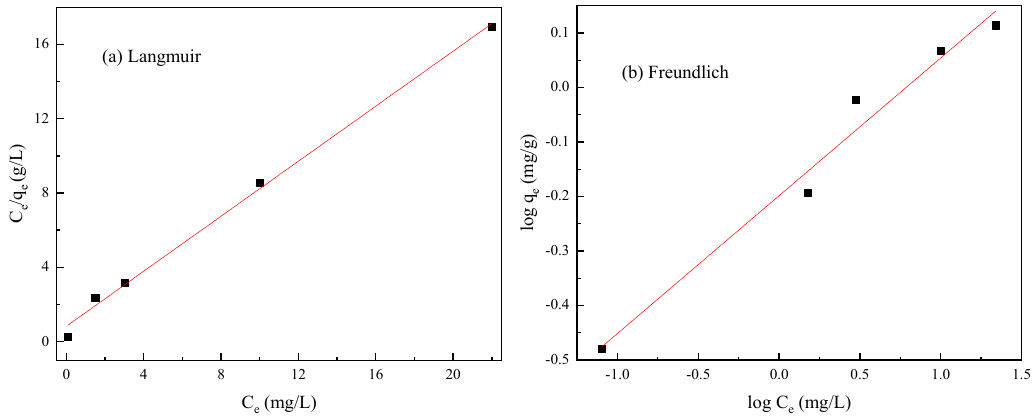
Figure 13. Schematic diagram of REC modification and Cr(VI) and Pb(II) adsorption. 4. Conclusions This investigation showed that the novel modifier Fe 3+ chemisorption on the REC surface improved its adsorption capacity for Cr(VI) and Pb(II). For Fe-REC, the potential exhibited a positive shift within the studied pH range. In the XPS survey spectra, significant characteristic peaks of Fe 2p appeared, which was the oxidation state of Fe(III) (Fe–O, Fe–OH, Fe–OOH) formed on the Fe-REC surface. The Cr(VI) adsorption mechanism was mainly due to the reaction between the iron hydroxy complex of modifier (FeOH 2+ , Fe(OH) 2+ and Fe(OH) 3 (aq)) and the major components of hexavalent chromium solution (HCrO 4– and CrO 42– ) to promote its adsorption behavior. From zeta potential results, there was an obvious negative shift after Cr(VI) ions was adsorbed by Fe-REC and the natural potential reduced to –33.2 mV from –2.21 mV. In XPS analysis, the binding energy of O 1s and Fe 2p changed a lot. This resulted in chemical changes of oxygen and iron elements during its adsorption. This adsorption process was consisted with Freundlich isotherm.